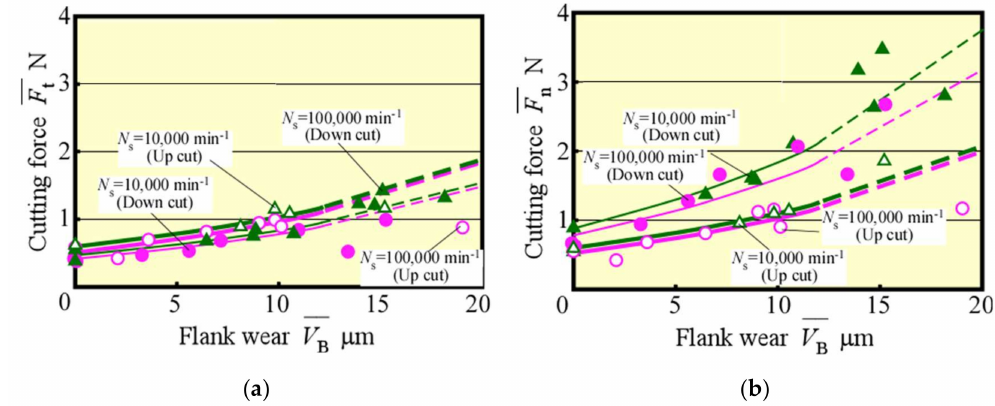
Figure 4. Relationship between flank wear and cutting force ( f = 5 µ m / tooth) ( a ) Normal cutting force ( b ) Tangential cutting